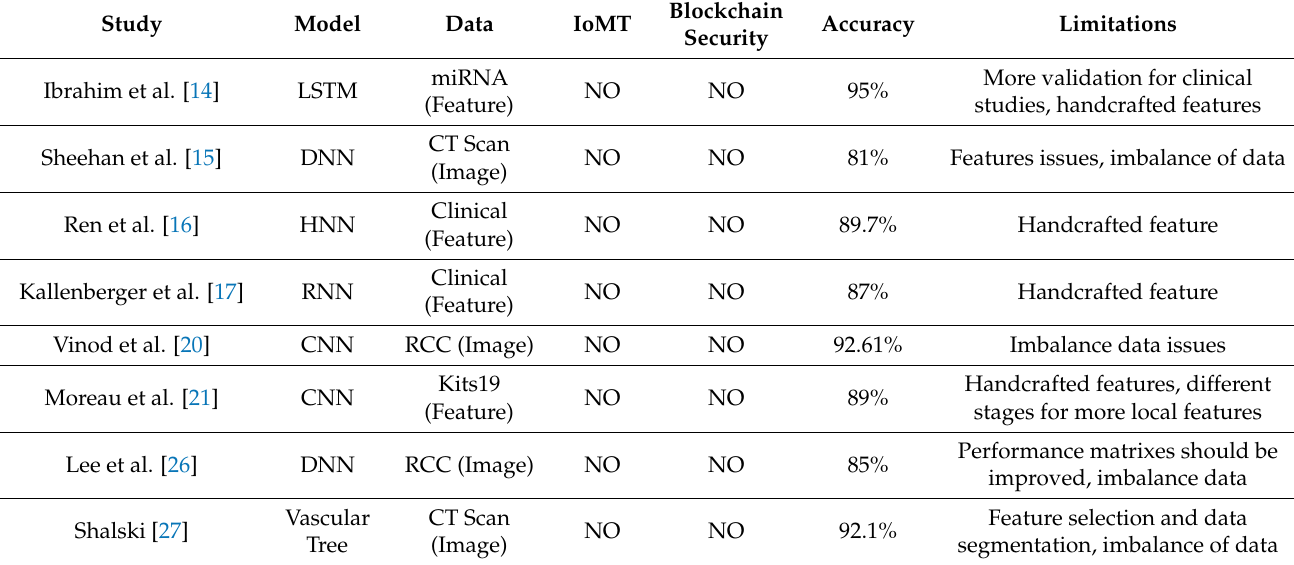
Table 1. Limitations of previous